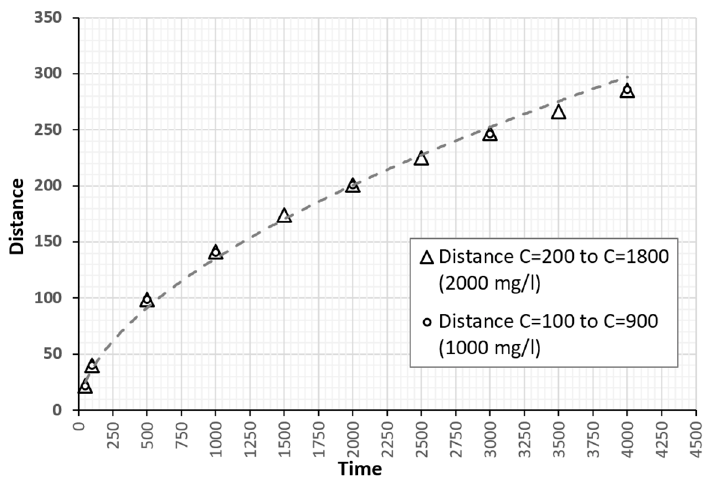
Figure 4. Distance between the fronts of concentrations 0.1c o and 0.9c o as a function of time. c o = 1000 and 2000 kg/m 3 , v o = 0.05 m/d.